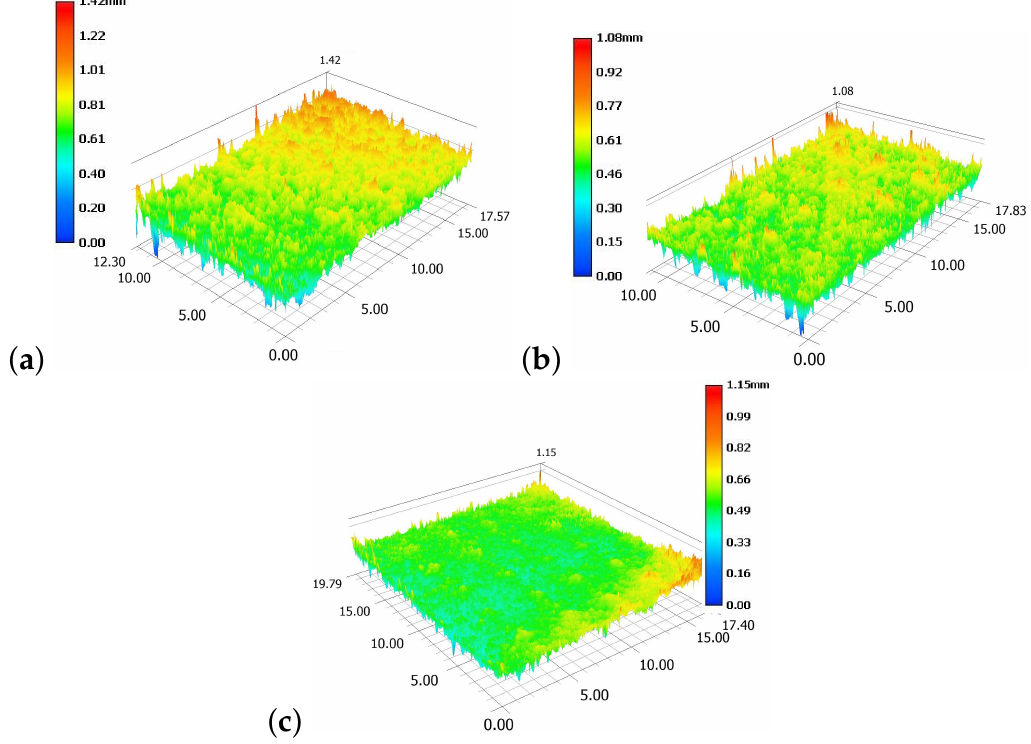
Figure 2. Surface analysis for all types of samples: PUR foam pounds per cubic foot (PCF) 10 ( a ), PUR foam PCF 25 ( b ), and PUR foam PCF 40 ( c ).